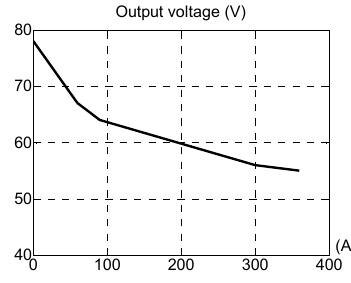
Figure 2. Polarization curve of the fuel cell.